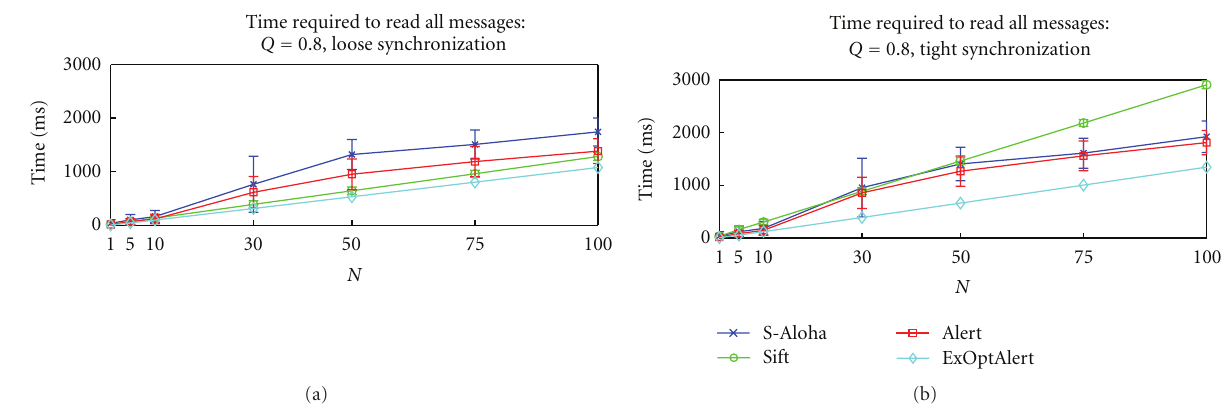
Figure 14: Average time required to receive all messages with Q = 0 .